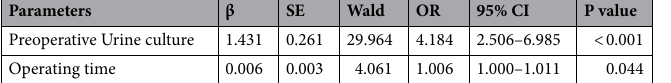
Table 2. Multivariate analysis results of risk factors for infection after